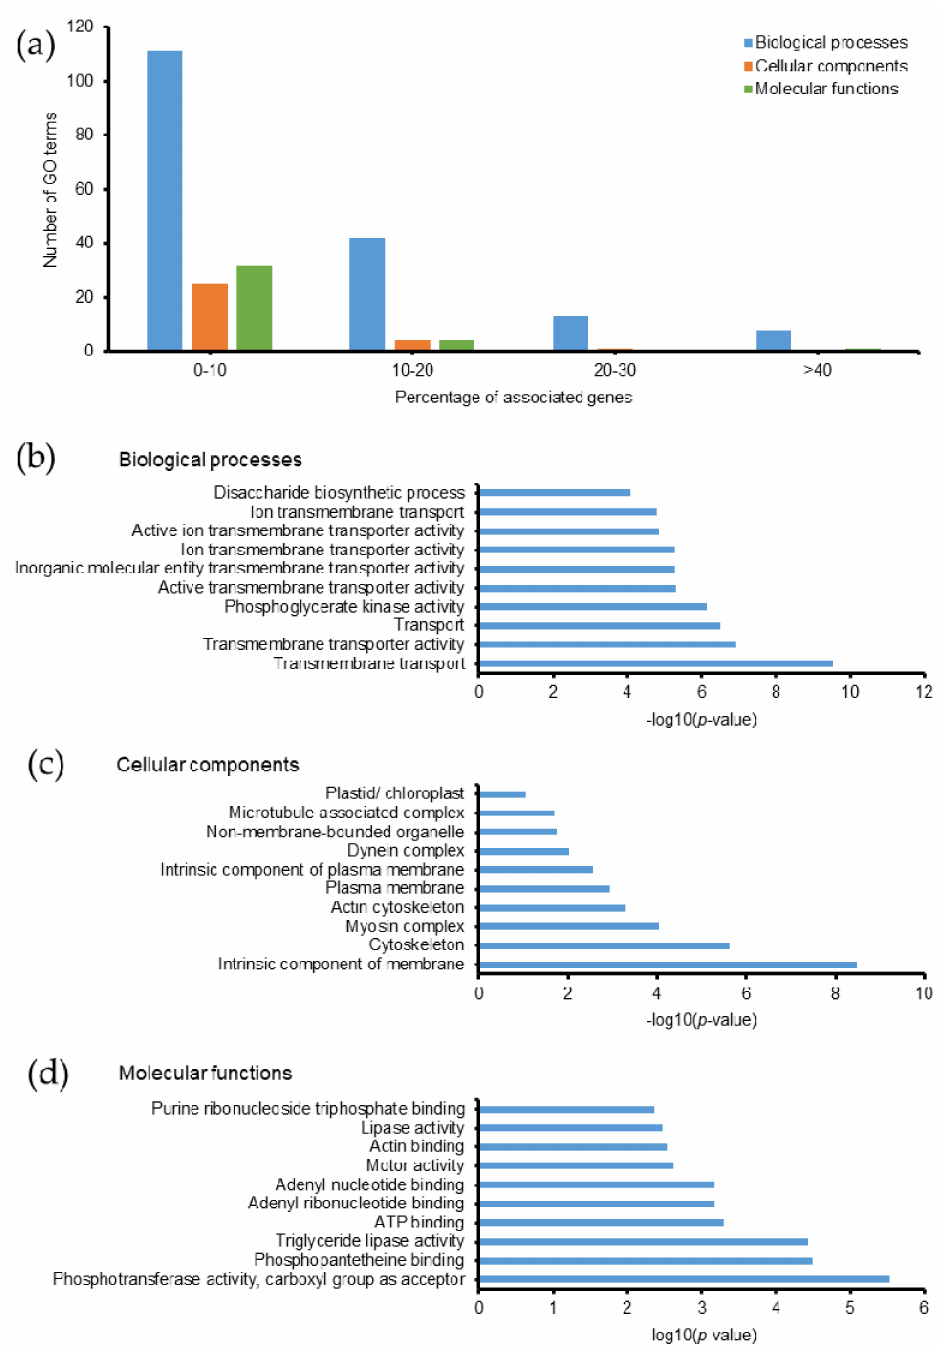
Figure 7. Gene ontology of phosphoylated proteins in Emiliania huxleyi using ClueGO. ( a ) Summary of the number of GO terms according to percentage associated genes. Top 10 ( b ) biological processes, ( c ) cellular components, and ( d ) molecular functions based on − log( p